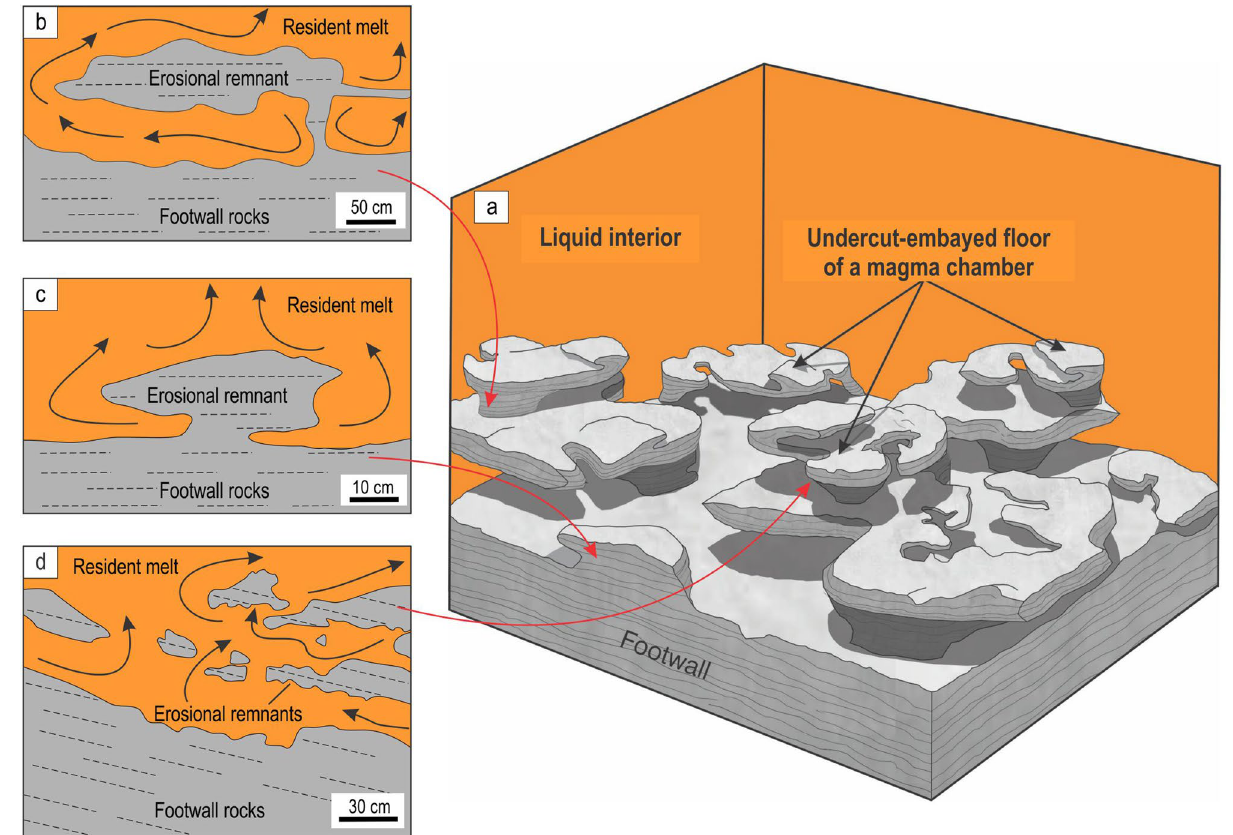
Figure 5. Artistic impression of the undercut-embayed chamber floor in an evolving magma chamber along with interpretive sketches of relevant exposures. (a) When the undercut-embayed floor is observed in three dimensions, it becomes obvious that most seemingly isolated ‘inclusions’ in two dimensions are actually connected with each other to produce an intricate in three-dimensional framework of partially eroded floor cumulates. The process responsible for the formation of such a floor is referred to as here as magmatic ‘karstification’. The undercut-embayed floor is expected to be common in open magma chambers. (b) Interpretive sketch of an erosional remnant of anorthosite that is hosted by the Main Magnetite Layer and is still attached to the footwall rocks. Vametco Vanadium Mine, Upper Zone of the Western Bushveld Complex (Fig. 6a). (c) Interpretive sketch of an erosional remnant of orthopyroxenite that is hosted by the Lower Group 6 (LG6) chromitite and is still attached to the footwall rocks. Jagdlust area, Lower Critical Zone of the Eastern Bushveld Complex (Fig. 6b). (d) Interpretive sketch of in situ erosional remnants of anorthosite that are hosted by the Merensky Reef orthopyroxenite and seemingly not attached to the footwall rocks in this section. Rustenburg Platinum Mine, Upper Critical Zone of the Western Bushveld Complex (Fig. 6e). Black arrowed curves in (b–d) show compositional convection. Red arrowed curves indicate possible positions of these 2D exposures in the 3D space of the undercut-embayed chamber floor. The figure is prepared using CorelDRAW (version